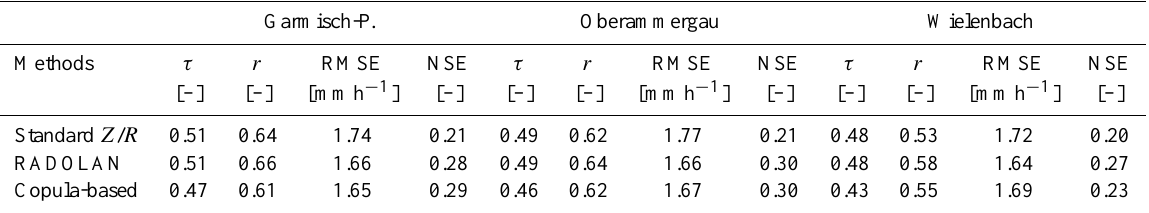
Table 7. Comparison of radar precipitation derived with the standard Z / R -relationship, the DWD RADOLAN-correction, pseudo- observations simulated with the Maximum Theta approach (all 31 stations included) to gauge observations for Garmisch-Partenkirchen, Oberammergau and Wielenbach (positive pairs, summer 2005–2008).